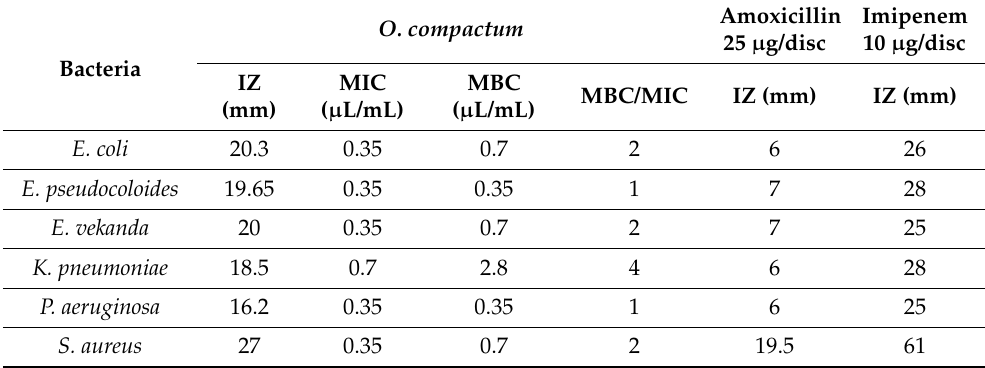
Table 4. Results of antibacterial activity of O. compactum essential oil.